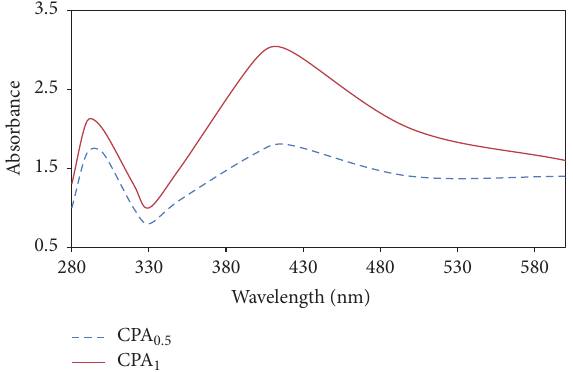
Figure 1: UV-Vis absorption spectra of CPA 0.5 and CPA 1